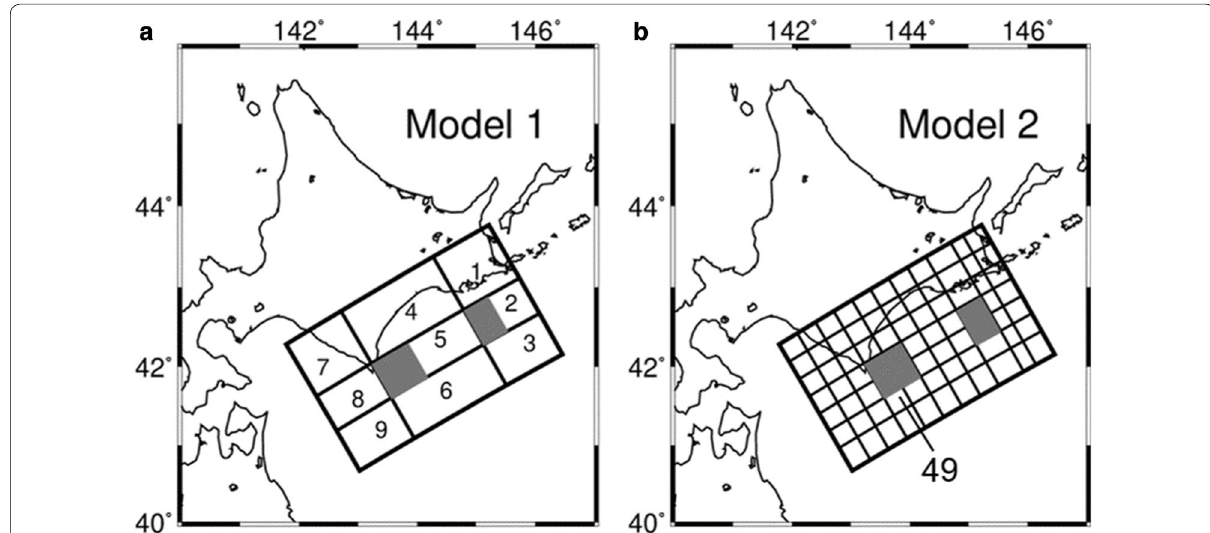
10 km subfaults. Two gray regions represent the ×